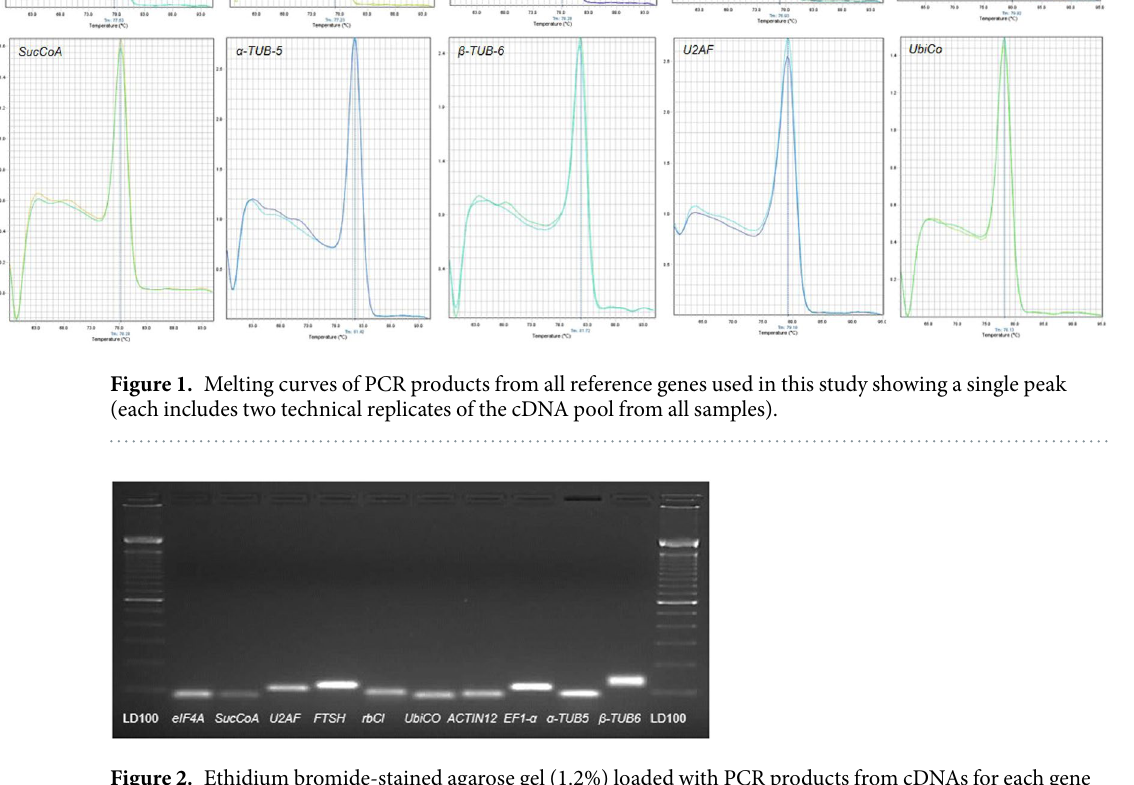
Figure 2. Ethidium bromide-stained agarose gel (1.2%) loaded with PCR products from cDNAs for each gene showing single amplificafion